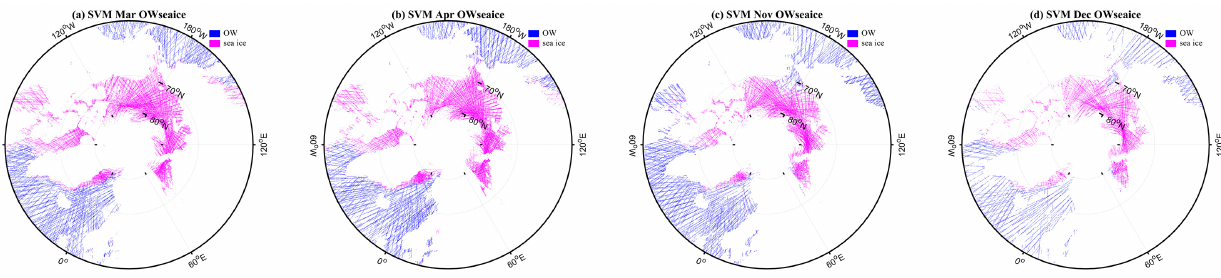
Figure A6. SVM for OW-sea ice classification using the data in February as the training set. The data in ( a ) March, ( b ) April,